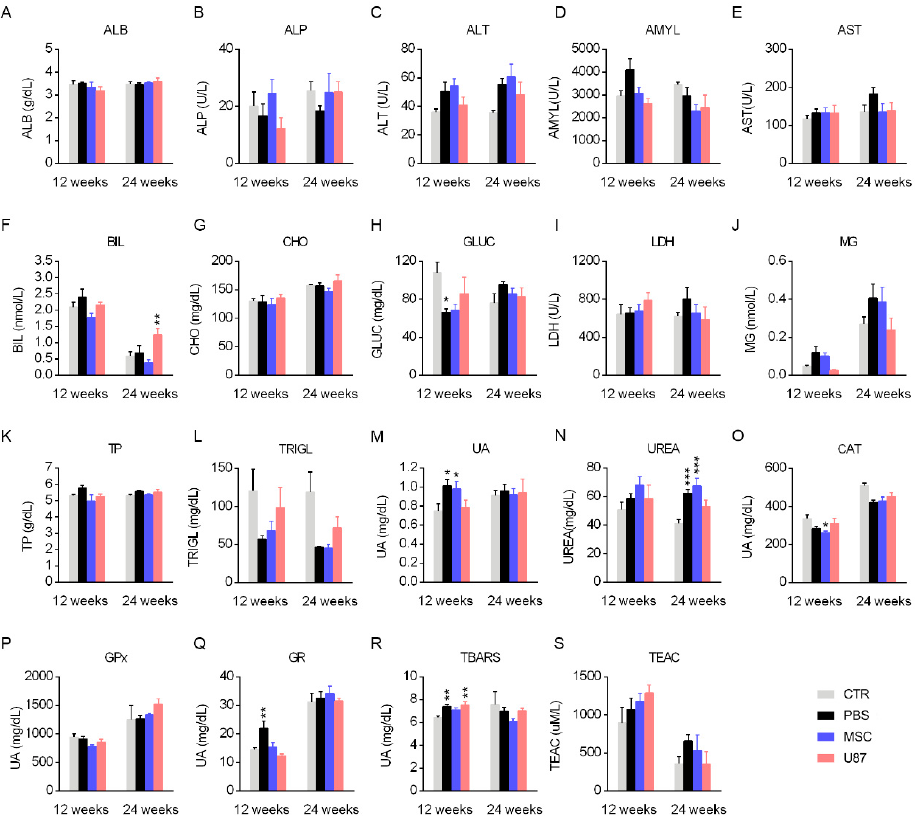
Figure 2. Biochemistry analysis and determination of oxidative stress-related parameters in blood samples. Determination of different biochemical parameters ( A – N ) and oxidative stress parameters ( O – S ) in overnight fasted mice, 12 and 24 weeks-post cell treatment. ALB, albumin; ALP, alkaline phosphatase; ALT, alanine aminotransferase; AMYL, amilase; AST, aspartate aminotransferase; BIL, bilirubin; CAT, catalase activity; CHO, cholesterol; GLUC, glucose; GPx, glutathione peroxidase; GR, glutathione reductase; LDH, lactate dehydrogenase; Mg, magnesium; TBARS, thiobarbituric acid reactive substances; TEAC, Trolox equivalent antioxidant capacity; TP, total proteins; TRIGL, triglycerides; UA, uric acid. Data are represented as mean ± SEM. n = 8–11 per group at 12 weeks-post cell treatment and n = 3–11 per group at 24 weeks-post cell treatment. * p < 0.05, ** p < 0.01, *** p < 0.001 compared to CTR group; One-way ANOVA.